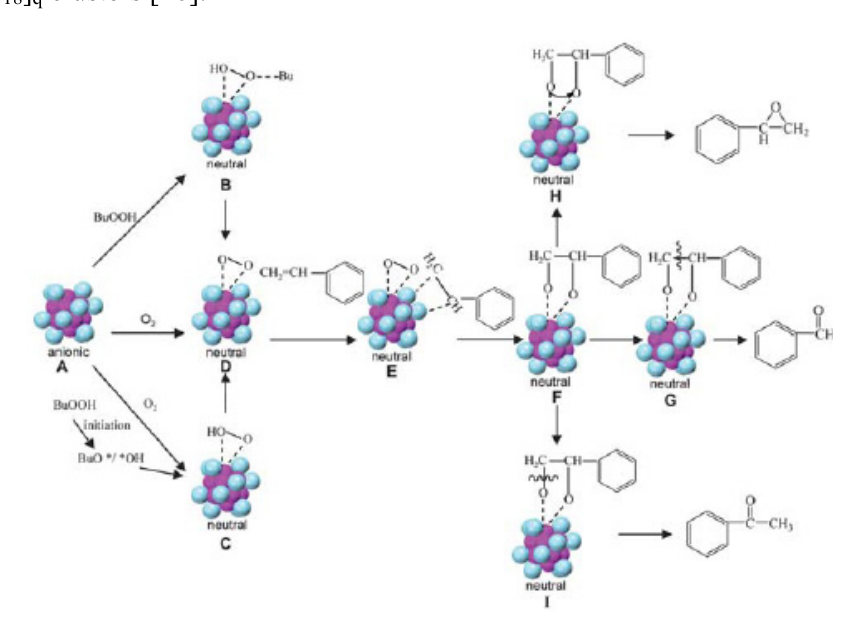
Figure 12. The proposed mechanism of selective oxidation of styrene catalyzed by [Au (SR) ] clusters 25 18 q